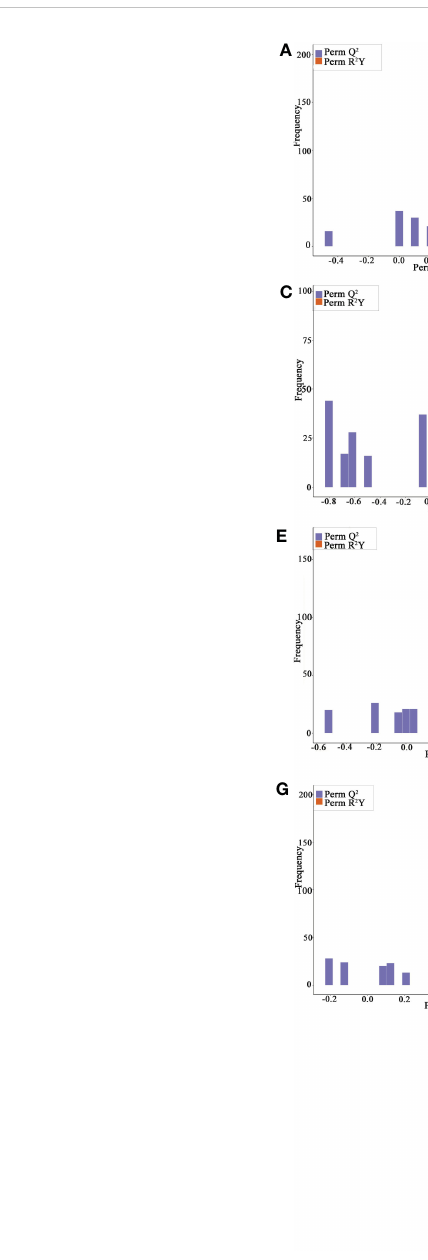
FIGURE 2 OPLS-DA Validation Chart, Y-R vs Q-R, Y-RP vs Q-RP, Y-RS vs Q-RS, Q-R vs Q-RP, Q-R vs Q-RS, Q-RP vs Q-RS, Y-R vs Y-RP, Y-R vs Y-RS, and Y-RP vs Y-RS (A-I) . The horizontal coordinate indicates the model R 2 Y, Q 2 values, and the vertical coordinate is the frequency of the model classi fi cation effect in 200 random permutation